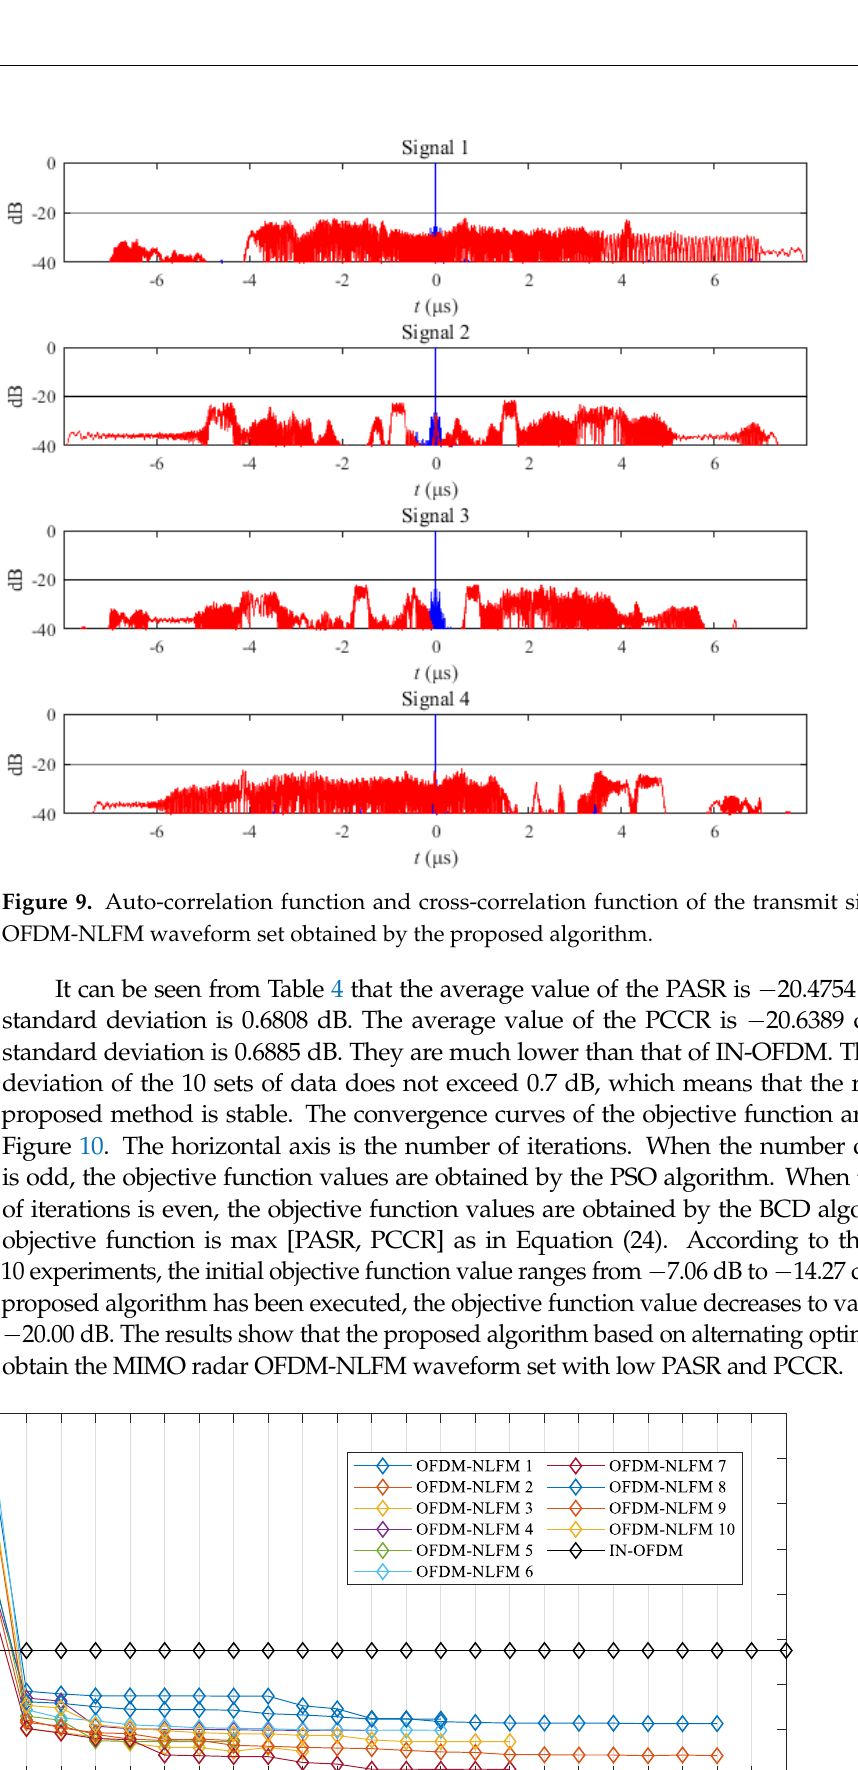
Figure 8. Time-frequency structure of the transmit signals of the OFDM-NLFM waveform set ob- tained by the proposed algorithm.